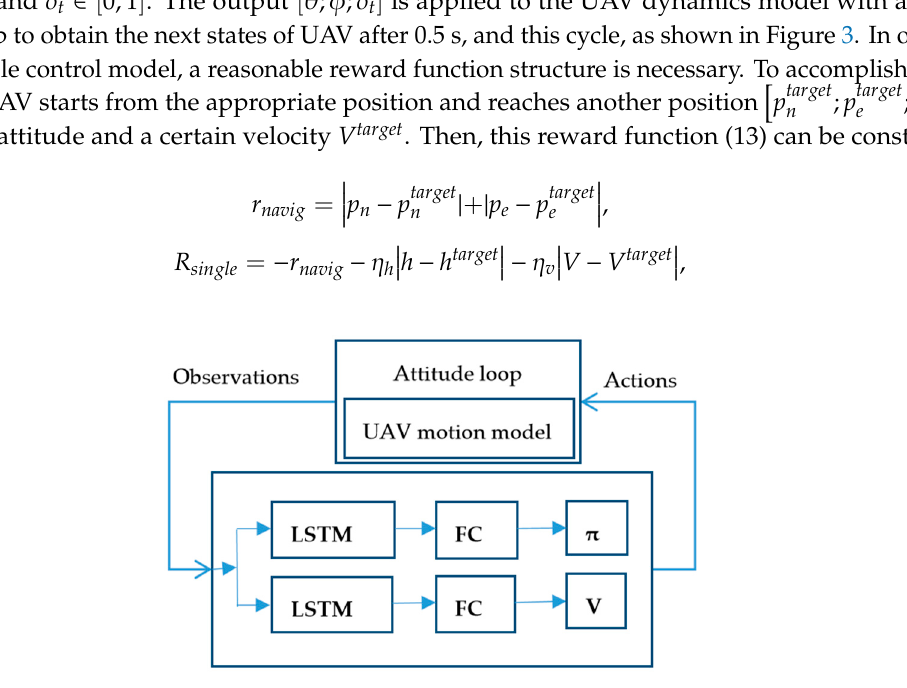
Figure 3. The single-agent PPO algorithm and the UAV motion model controlled by attitude loop for the feedback loop.